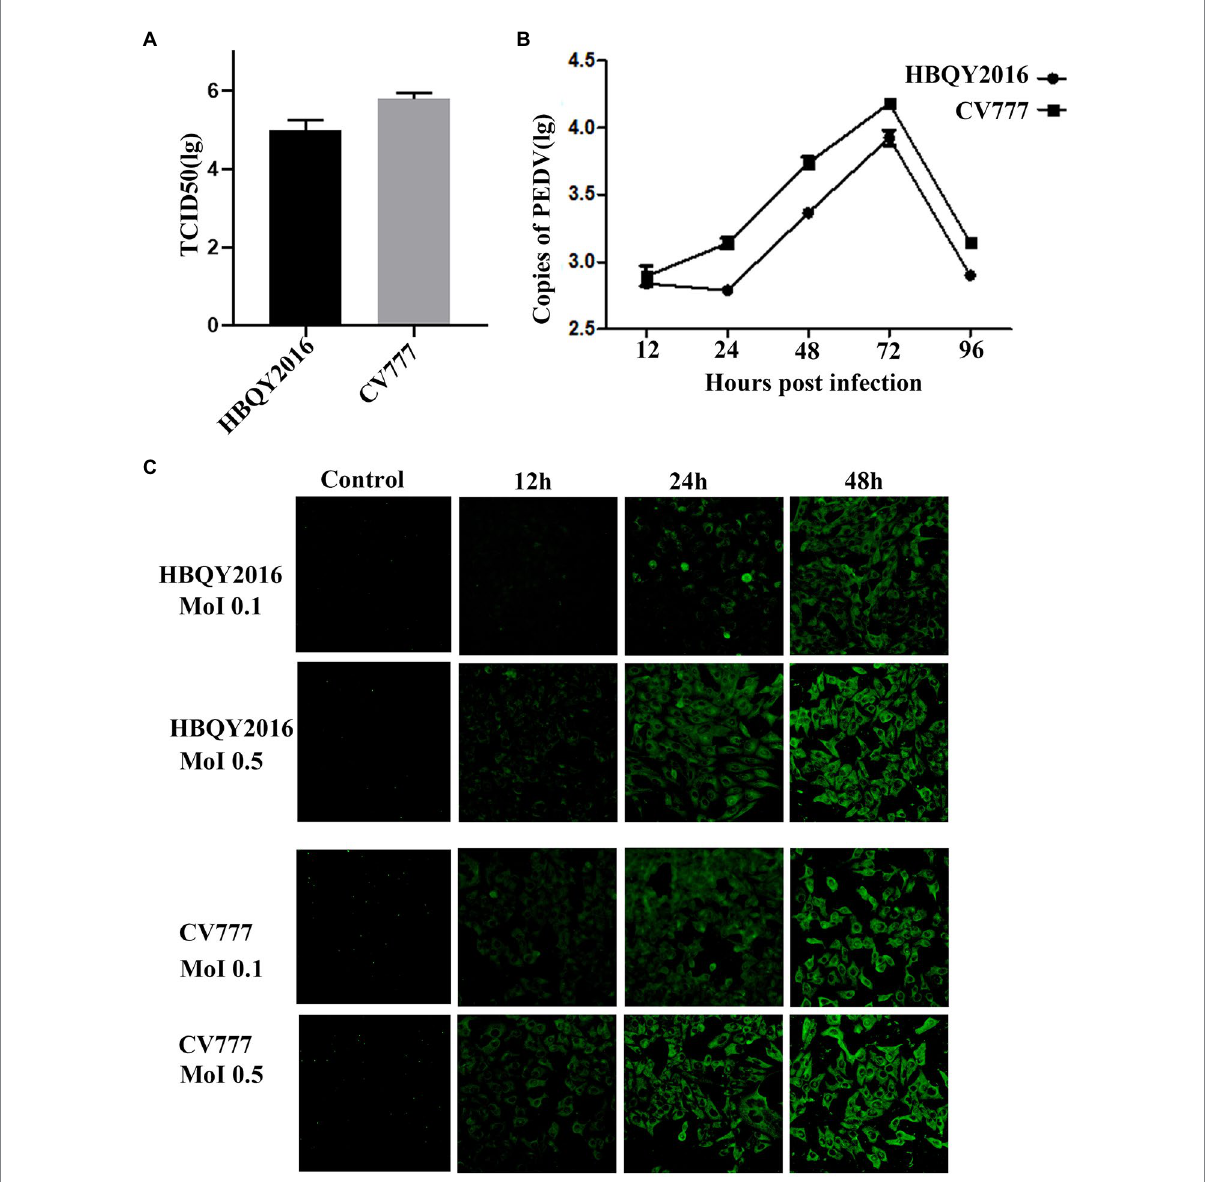
FIGURE 2 Replication of PEDV in IPEC-J2 cells. (A) The viral titer of PEDV-HBQY2016 or -CV777 strain was determined with IPEC-J2 cells with the results expressed as TCID 50 /mL at 72 h post infection. (B) The copies (Log10) of PEDV-HBQY2016 or PEDV-CV777 strain in IPEC-J2 cells at different time points was evaluated by RT-qPCR. (C) Immunofluorescence staining of IPEC-J2 cells infected with PEDV-HBQY2016 or -CV777 strain at different time